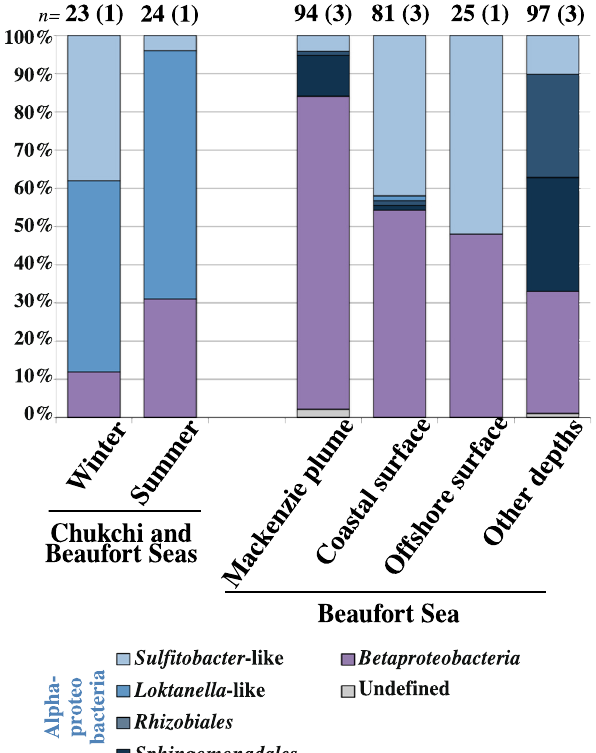
Figure 4. Relative abundance of puf M genes in clone libraries obtained from Arctic Ocean samples. Clones were retrieved from coastal samples of the Chukchi and Beaufort seas in summer and winter (Cottrell and Kirchman, 2009) and from the Mackenzie plume, coastal and offshore surface waters and other depths (Boeuf et al., 2013). The numbers of clones and libraries analyzed are indi- cated in bold and between brackets,